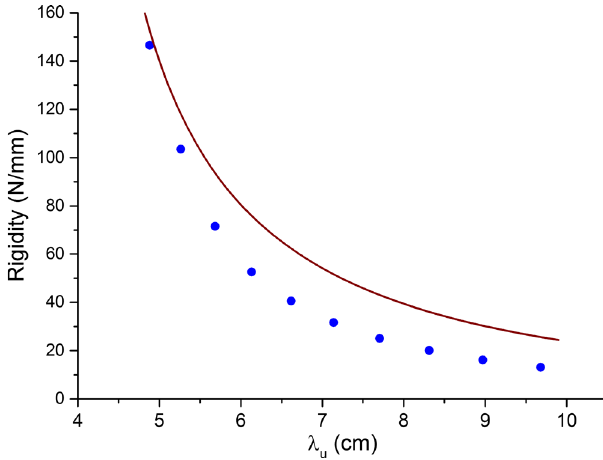
FIG. 12. Rigidity, N = mm, vs undulator period, cm. Dots: numeric calculations; solid line: analytic estimate in Eq.